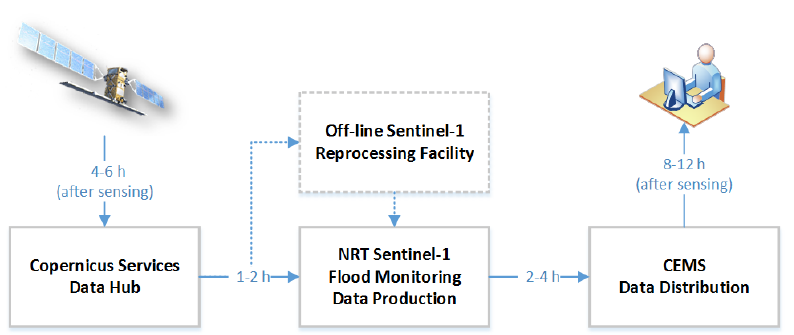
Figure 5. Data flow and envisaged data latencies (time delays) from the Copernicus Service Data Hub to the CEMS data distribution facilities. Note that the indicated timeliness of 8-12 hours represents the total time from Sentinel-1 data acquisition to flood monitoring product distribution to